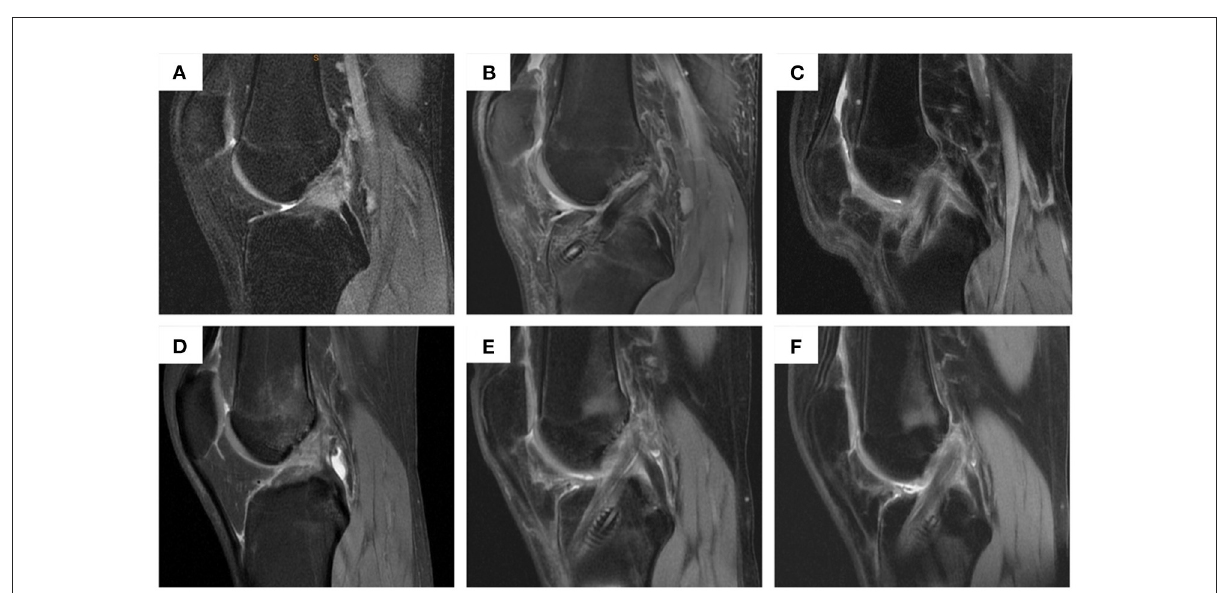
FIGURE4 MRI examination of patients in group 1 and group 2 before operation and at 3 and 6 months post-operation. (A) patients in group 1 before operation; (B) patients in group 1 at 3 months post-operation; (C) patients in group 1 at 6 months post-operation; (D) patients in group 2 before operation; (E) patients in group 2 at 3 months post-operation; (F) patients in group 2 at 6 months